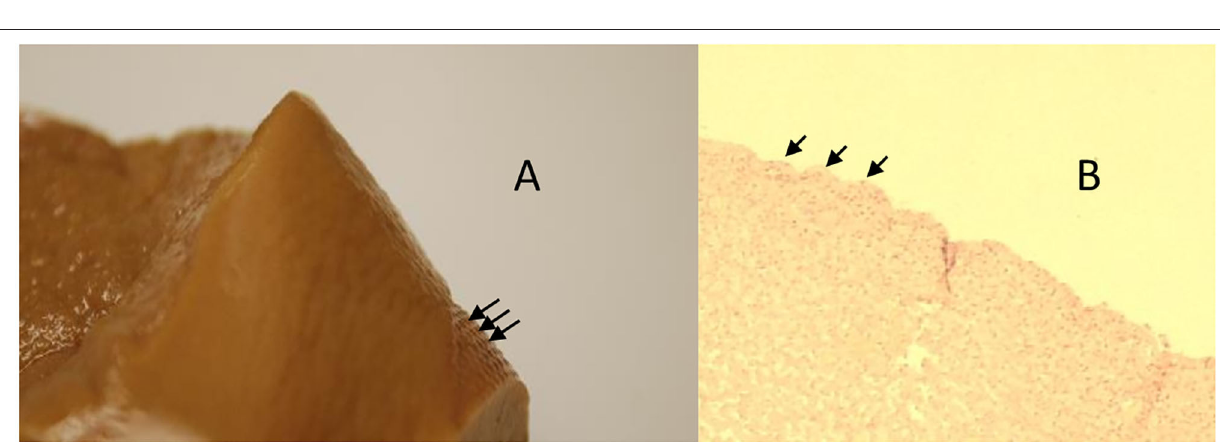
in the intestinal wall, begins even with stronger suction values of − 80 mmHg and more. Lindstedt et al. (14) describe only a slight protective effect of the protective disc at − 120 mmHg